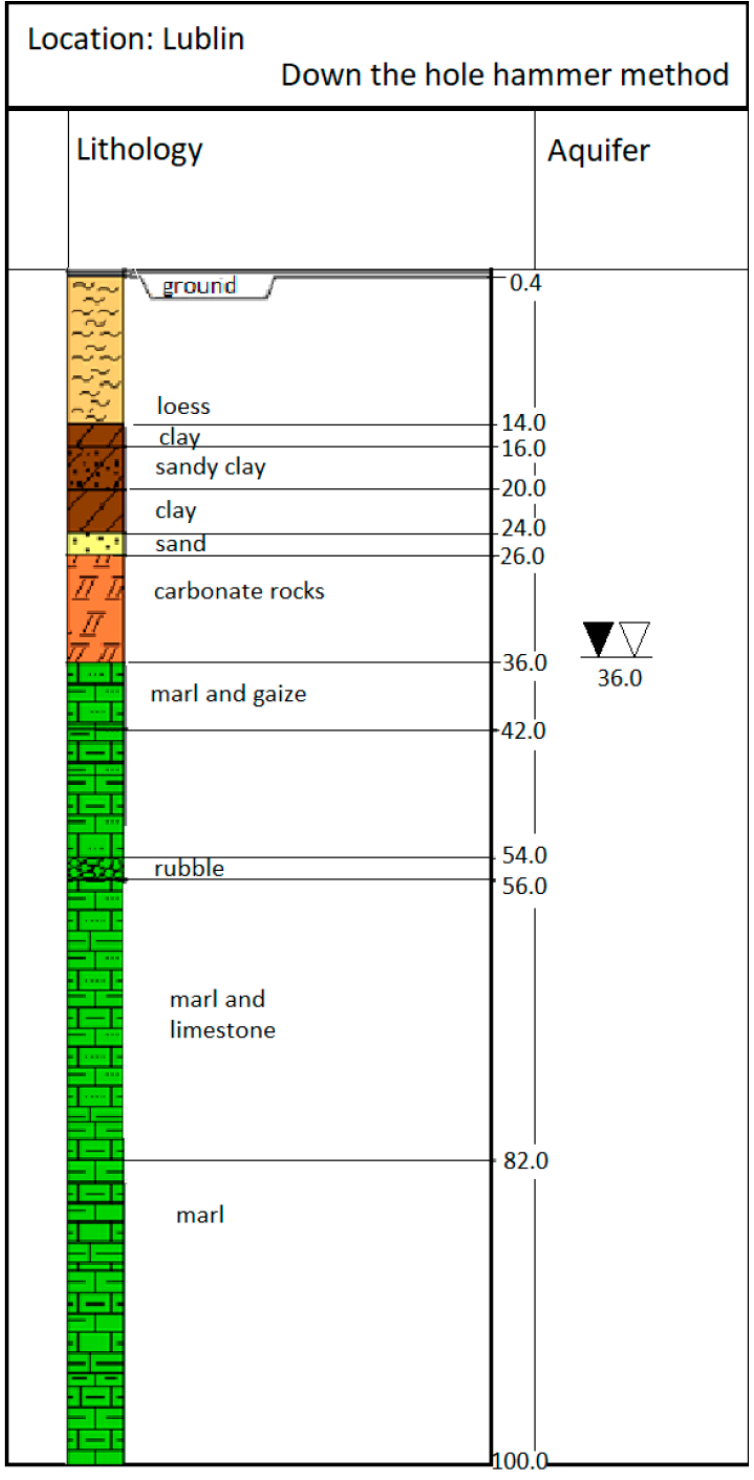
Figure 8. Geological profile and filtration schematics of the test borehole, which is common for every borehole under study [46].